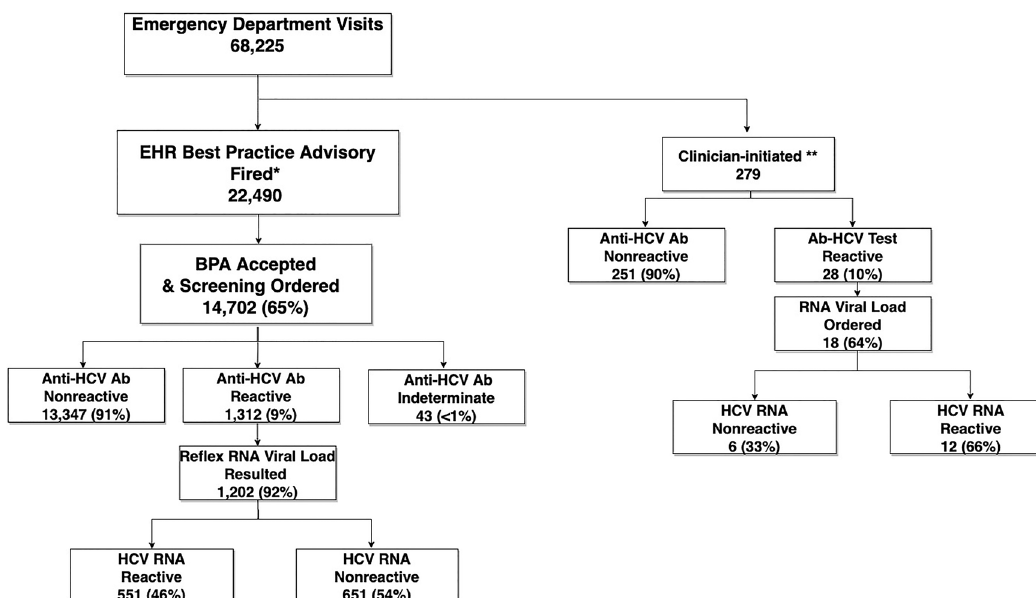
Figure 2. Hepatitis C virus testing schematic for the post-best practice advisory period. *Data for unique patients 18 years of age and born after 1945. **Testing was initiated by physician on the basis of perceived Hepatitis C risk behaviors or clinical manifestations of infection. EHR, electronic health record; BPA, best practice advisory; ABHCV, antibody-hepatitis C virus.